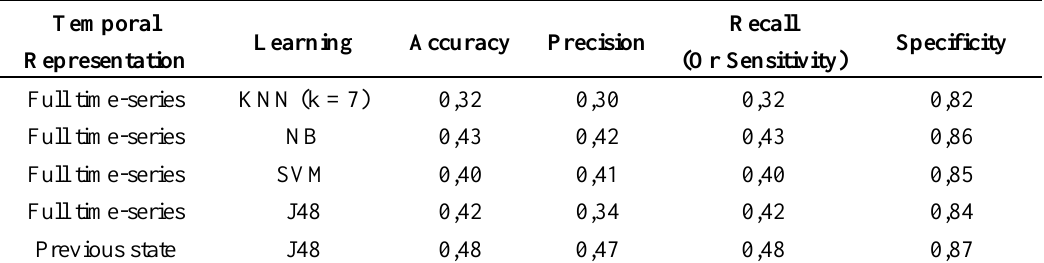
Table 3. Prediction of executive functions of people with